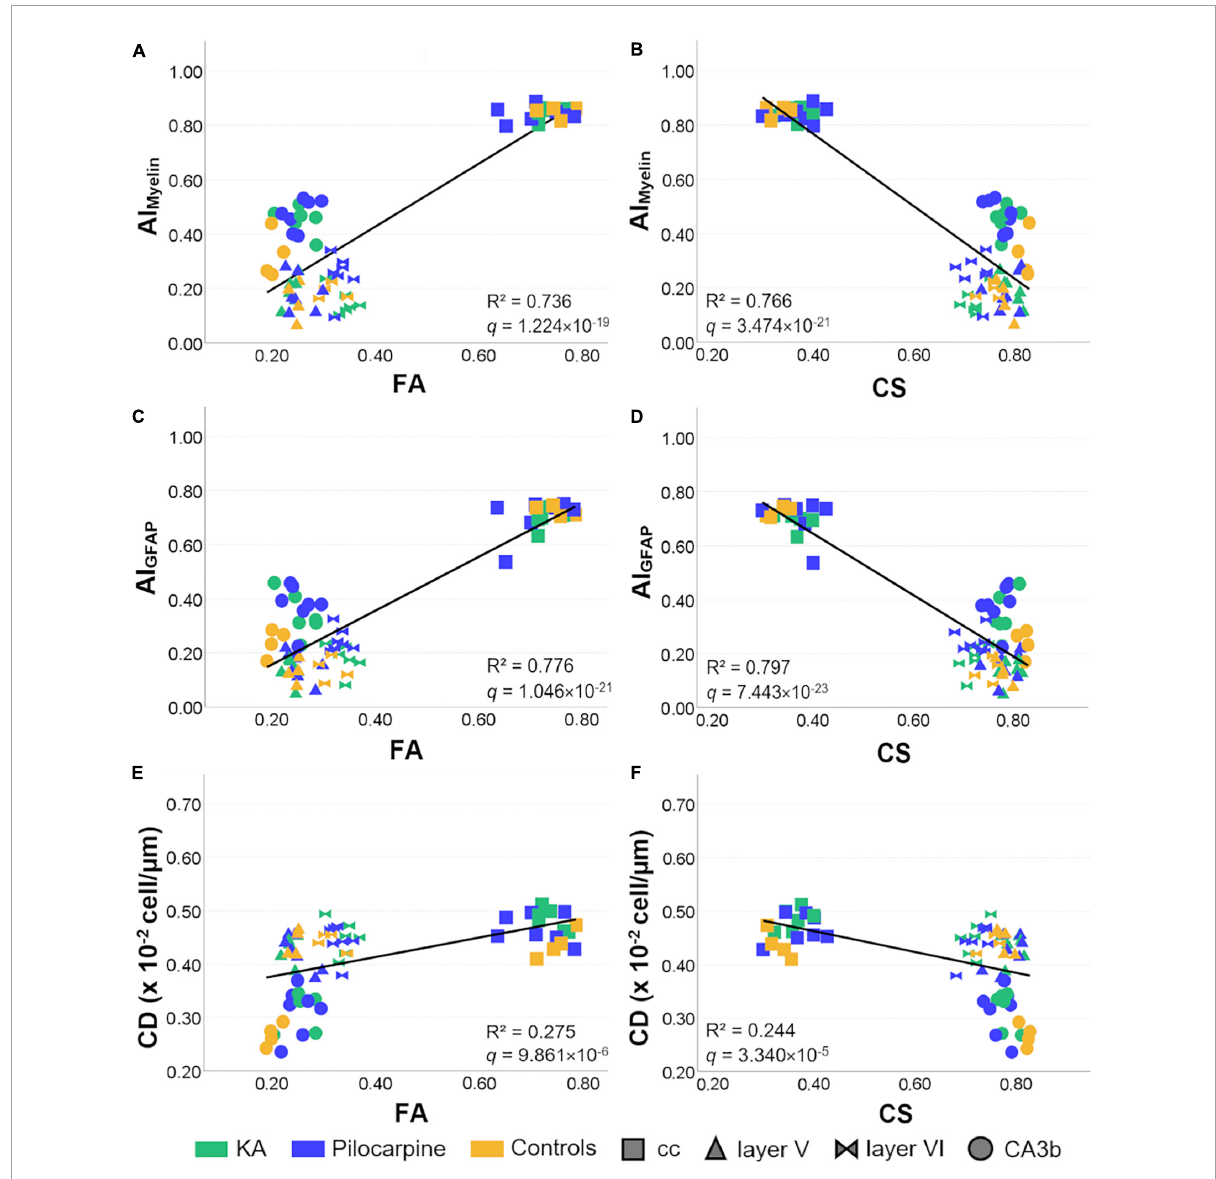
FIGURE8 Representative relationships between DTI and histological parameters in all selected brain regions. The line represents the regression fit between histological and DTI parameters. Controls and status epilepticus animals are represented by colors, while brain regions by shapes. FA and CS showed large effects in AI Myelin and AI GFAP (A–D) , while medium in CD (E,F) when analyzing the relationships between DTI and histological parameters individually. R 2 and BH-FDR corrected q -values for the univariate Pearson’s correlation between DTI and histological parameters are shown in each graph. FA, fractional anisotropy; AI, anisotropy index; CA, cornus ammonis; cc, corpus callosum; CD, cell density; CS, spherical